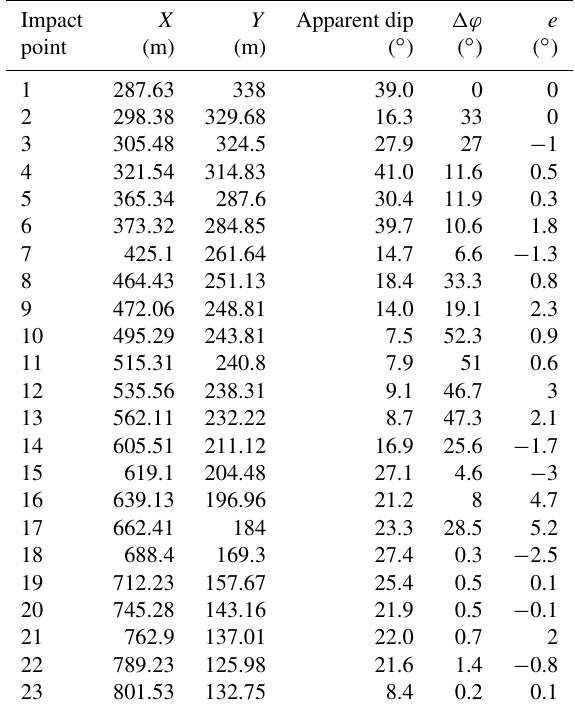
Table 2. Impact points